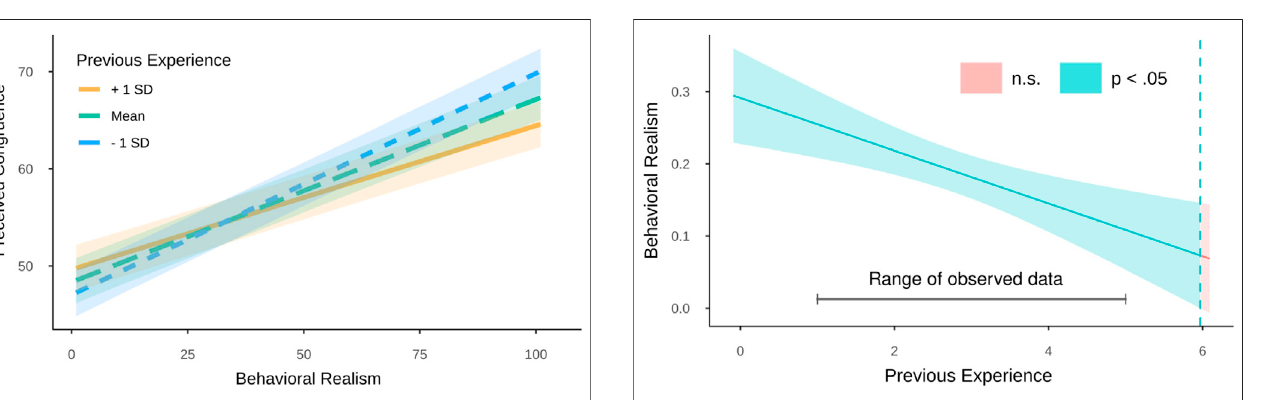
FIGURE 13 | The Johnson-Neyman plot shows the threshold of previous experience (blue dashed line) for a signi fi cant effect of behavioral realism on perceived